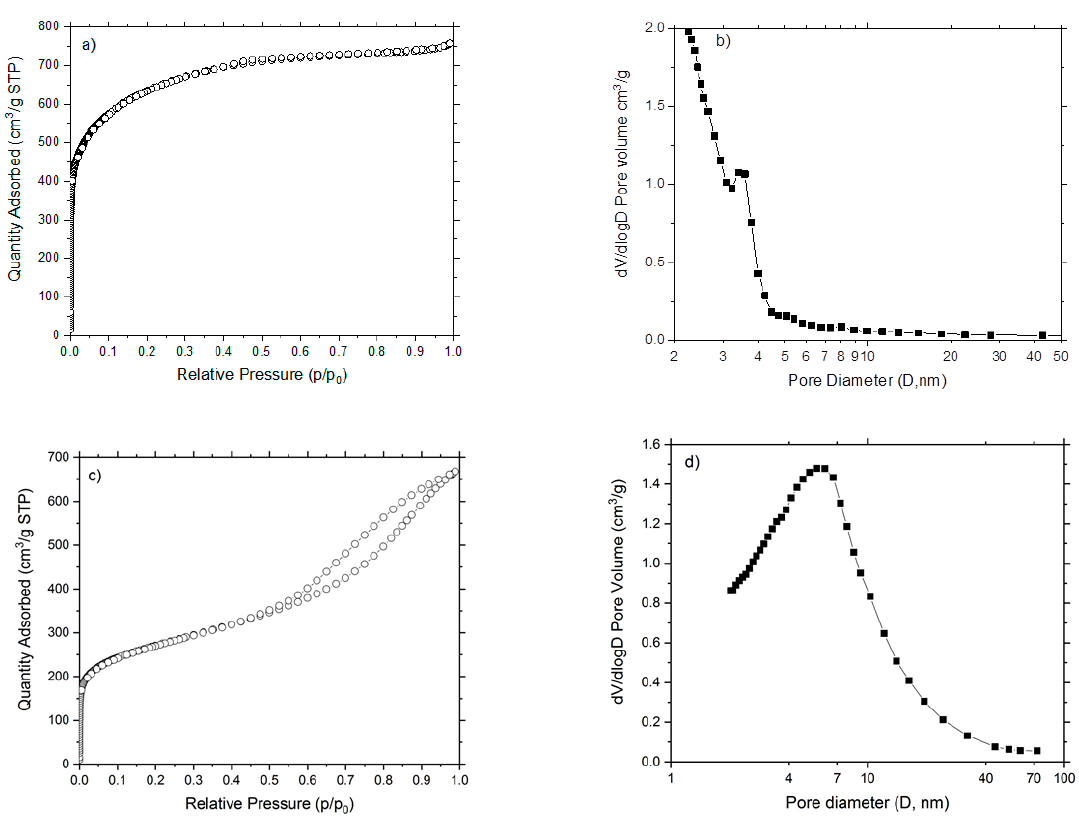
Figure 1. Adsorption isotherms and pore size distributions of ( a , b ) AC-CA and ( c , d ) AC-PA.